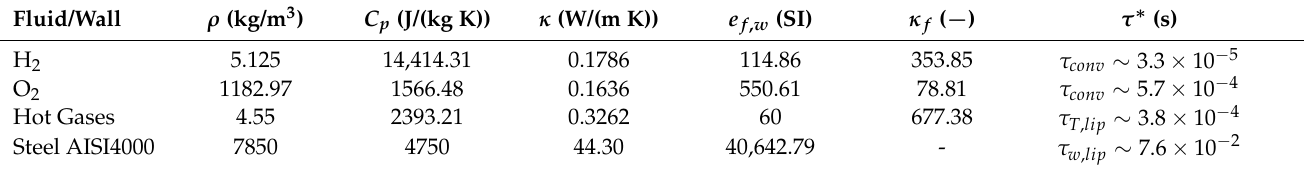
Table 3. Estimation of effusivity fluid ratio for the fluids adjacent to the tip of the tapered lip oxygen injector. Effusivities are in SI units. Characteristic times are also reported and